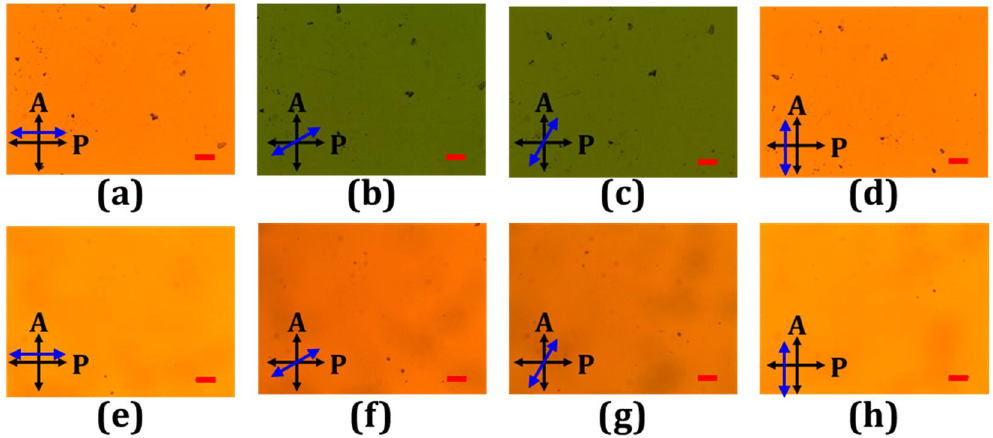
Figure 10. Crossed-polarized POM images of the conventional 90°-TNLC [tandem-90°-TNLC] cell when the β angles of the POM broadband backlight were ( a ) [( e )] 0°, ( b ) [( f )] 30°, ( c ) [( g )] 60°, and ( d ) [( h )] 90°. Blue arrow, red scale bar, A, and P are the director of the LCs close to the substrate facing the backlight of the POM, the length of 100 μ m, and the transmissive axes of the analyzer and the polarizer,